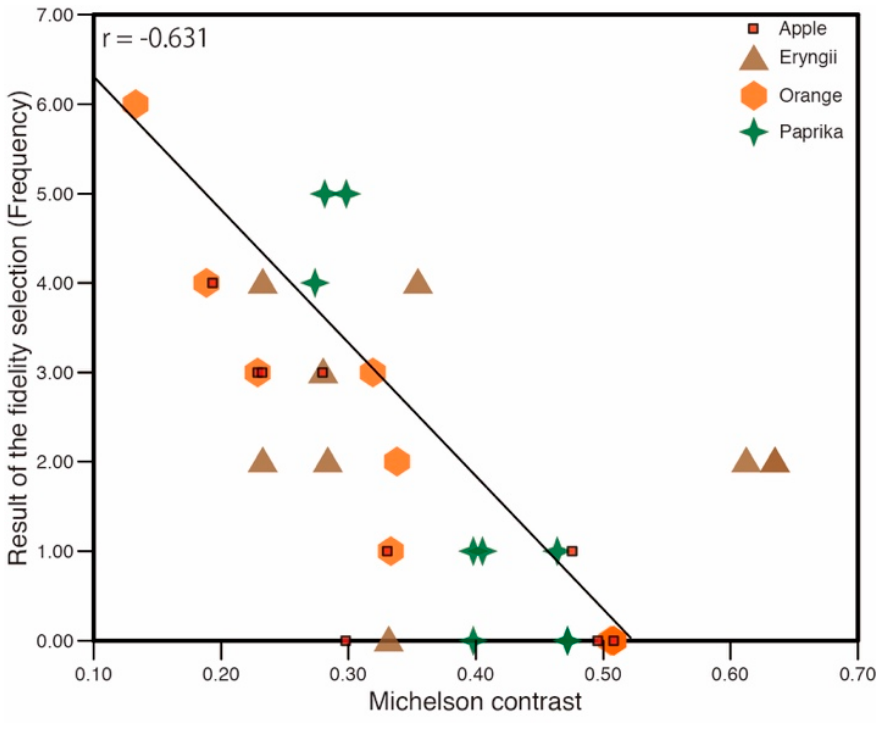
Figure 21. Correlation between luminance contrast and fidelity selection.